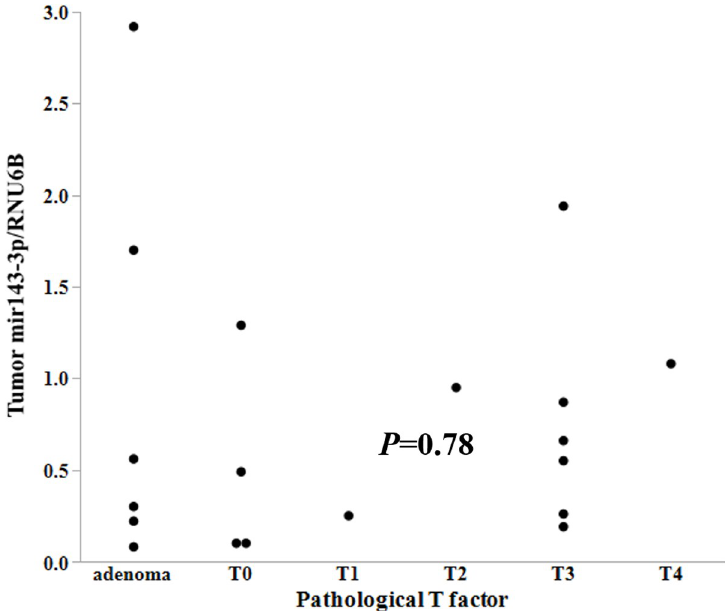
Fig 3. MiR-143-3p expression in colonic tumors. Expression levels of miR-143-3p relative to RNU6B are plotted versus pathological T factor. There was no significant difference in the expression of miR-143-3p relative to pathological T factor ( P =